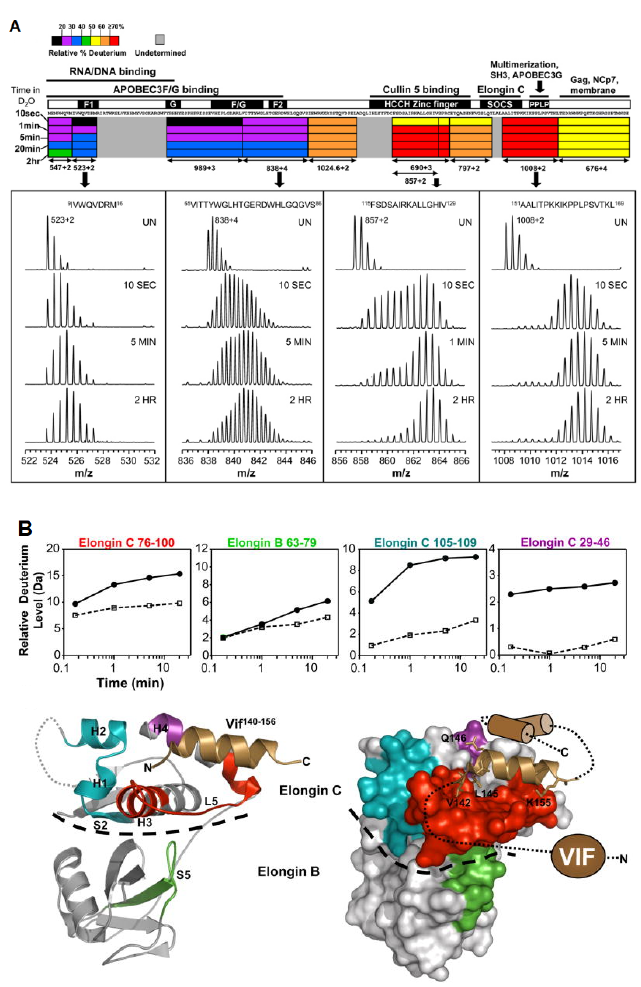
Figure 6. ( A ) The deuteration map for recombinant Vif. The bars are colored according to the relative percent deuterium incorporation as indicated in the legend. Additionally indicated are the different regions of Vif and their corresponding biological functions. Representative spectra of four peptides are shown, with deuteration times included in each panel; UN represents an undeuterated protein. Reproduced with permission from Elsevier Ltd. © 2011. ( B ) Location of conformational changes in Elongin B and C induced by HIV-1 Vif interaction. Deuterium uptake curves for Elongin B and C peptides that displayed changes in deuterium uptake upon interaction with Vif are shown in the top panel. The solid lines represent the Elongin BC complex alone, and the dotted lines represent the Elongin BC complex bound to Vif. The changes are mapped onto the structure of the Vif 140–156 . Elongin BC complex. The colors in the top panel correspond to those mapped onto the structures. Areas that are grey indicate regions with no change in deuterium uptake or those which were not covered. The HIV-1 Vif peptide 140–156 is represented as the copper helix, and the remaining structurally uncharacterized regions of Vif are depicted in cartoon form. A dotted line indicates the boundary between Elongin C and Elongin B. Reproduced with permission from Elsevier Ltd. (© 2010).